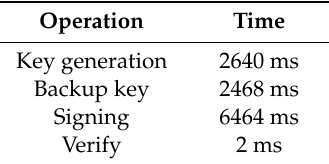
Table 1. This is a table of Secure Multi-Party Computation (SMPC) two-party implementation execution